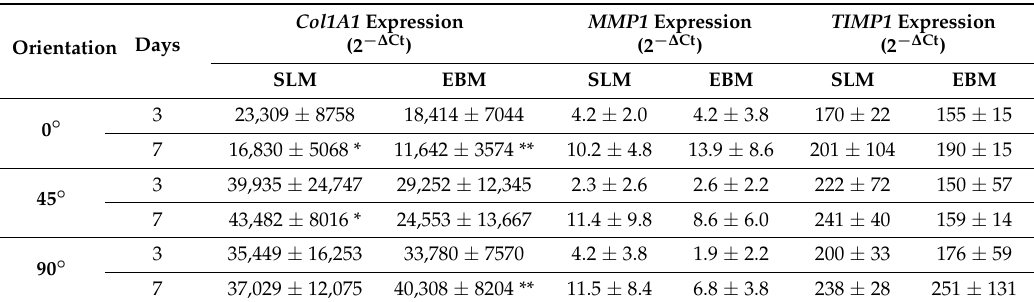
Table 2. Gene expression analyses of bone formation ( Col1A1 ) and degradation ( MMP1 , TIMP1 ) marker. Human osteoblasts were seeded on top of the different test specimens. After 3 and 7 days, RNA was isolated and reverse transcribed to determine mRNA levels of Col1A1 , MMP1 and TIMP1 by qRT-PCR. Results are shown as mean values ± standard deviations ( n = 3). Statistically significant results are marked with * for p < 0.05 and ** for p < 0.01 (repeated measures two-way ANOVA test with Bonferroni’s multiple